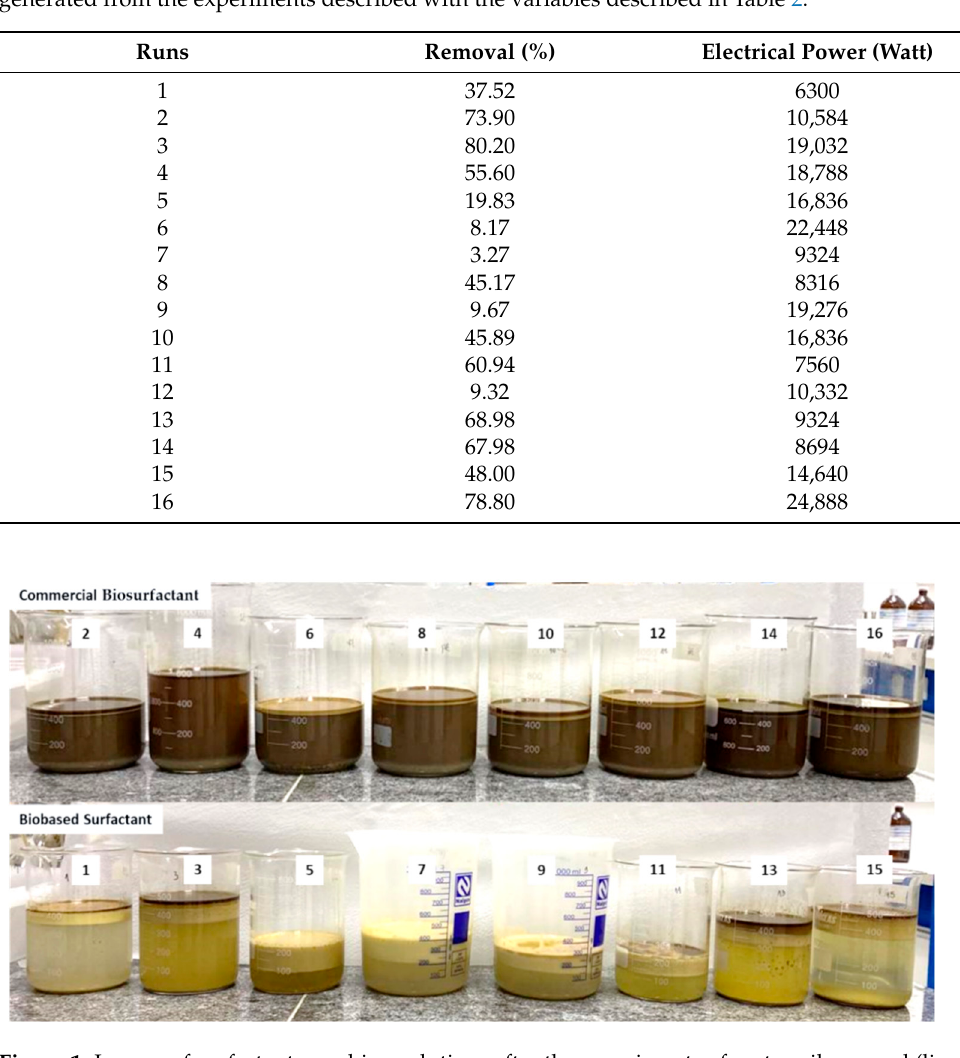
Table 7. Removal efficiency and energy consumption according to the evaluated factors. Results generated from the experiments described with the variables described in Table 2.